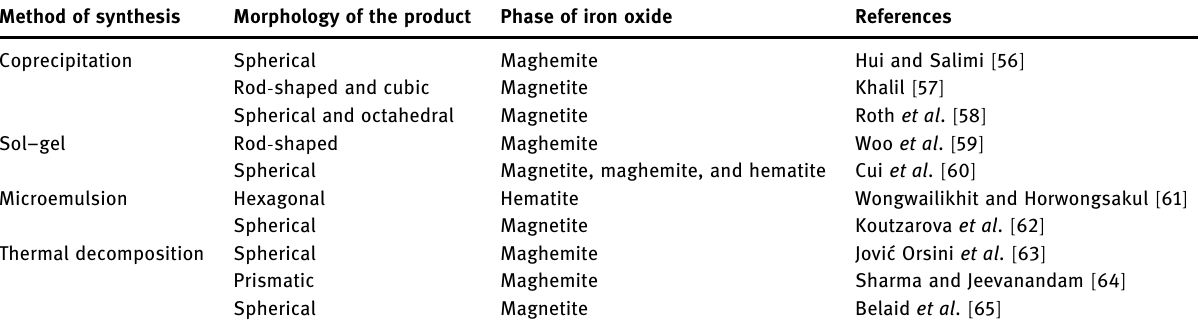
Table 1: Methods of iron oxide prepared using some of these methods and the morphology and phase properties of the nanoparticles Method of